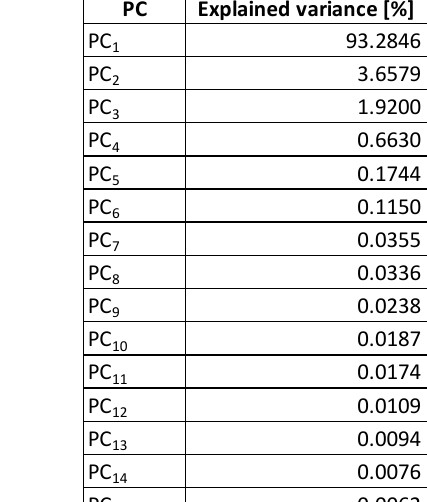
12 of 24 Figure 5. Correlation coefficient matrix (description: indicators numbers identical to Table 1).